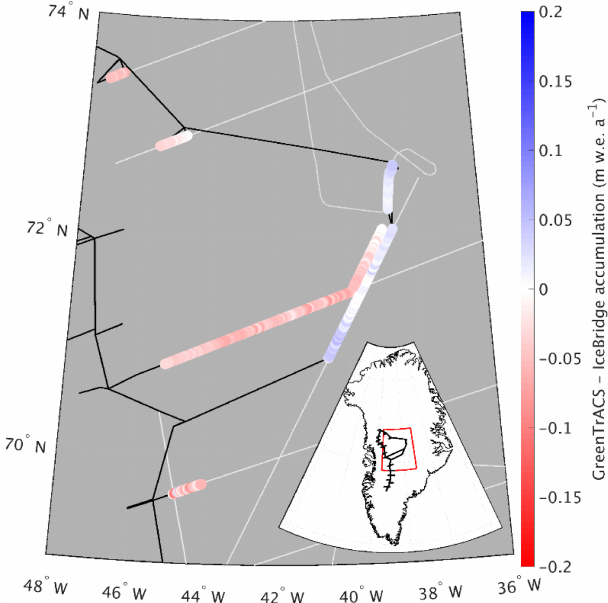
Figure 6. Difference between averaged (1966–2016) GreenTrACS accumulation and average (1962–2014) IceBridge Accumulation Radar rates from Lewis et al. (2017) across all 562.5km of overlap. Spatially overlapping section of 2016 and 2017 traverses displayed as adjacent tracks. Also showing extent of GreenTrACS traverse (black) and IceBridge accumulation radar (grey). Inset shows map location with respect to GreenTrACS traverse